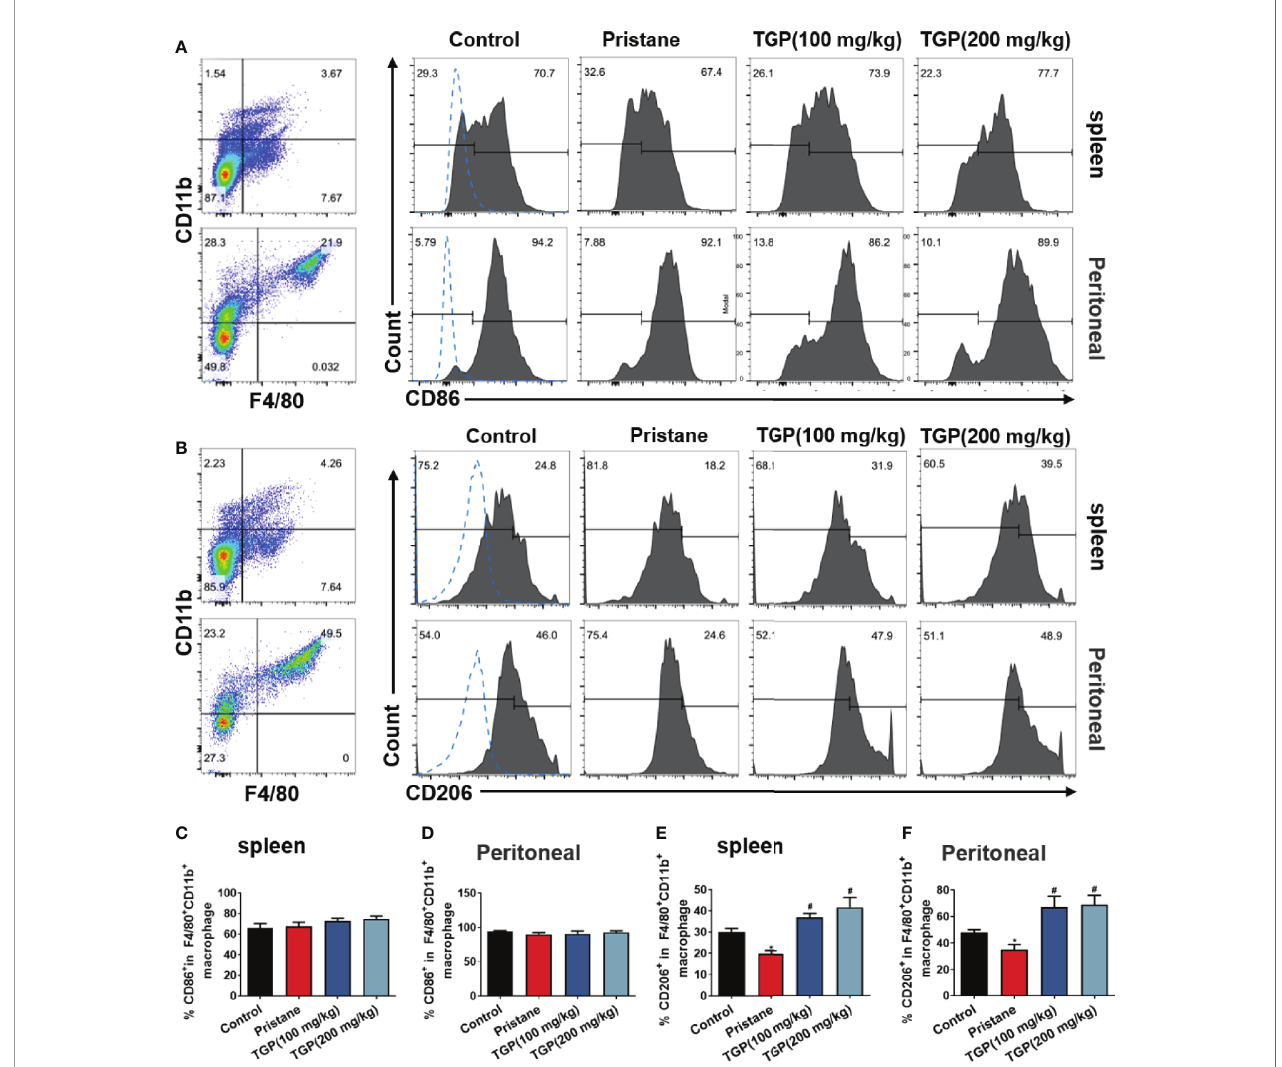
FIGURE 2 | TGP treatment promotes macrophage M2 polarization in pristane-induced lupus mice. Single-cell suspensions from spleens and peritoneal lavage fl uids were collected 8 weeks after TGP treatment following pristane injection 24 weeks ago. The effects of TGP on the frequency of CD86 + (A) and CD206 + (B) subsets in the splenic and peritoneal F4/80 + CD11b + macrophages were analyzed via fl ow cytometry. (C, D) The percentages of CD86 + subset in splenic and peritoneal F4/ 80 + CD11b + macrophages are shown as means ± SD. (E, F) Shown also are the means ± SD of the percentages of CD206 + subset in splenic and peritoneal F4/ 80 + CD11b + macrophages. (n=6, *p < 0.05 compared with control, and # p<0.05 compared with pristane-treated